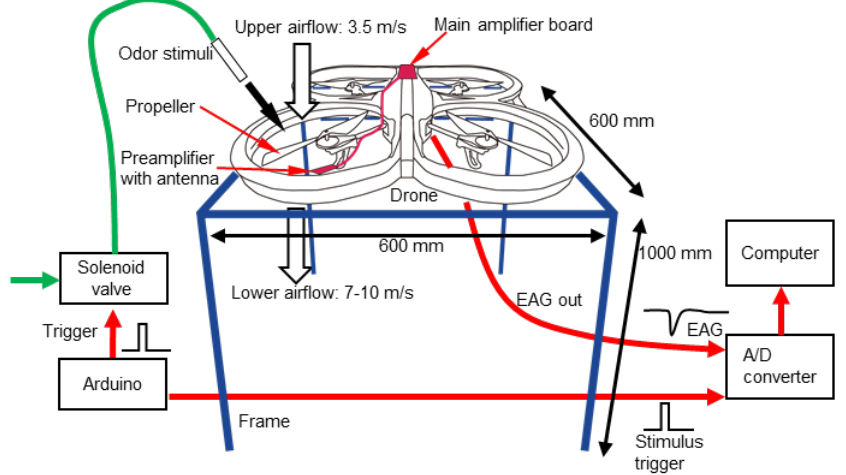
Figure 3. Tethered flight setup illustration. The preamplifier with the antenna was fixed under the propeller.